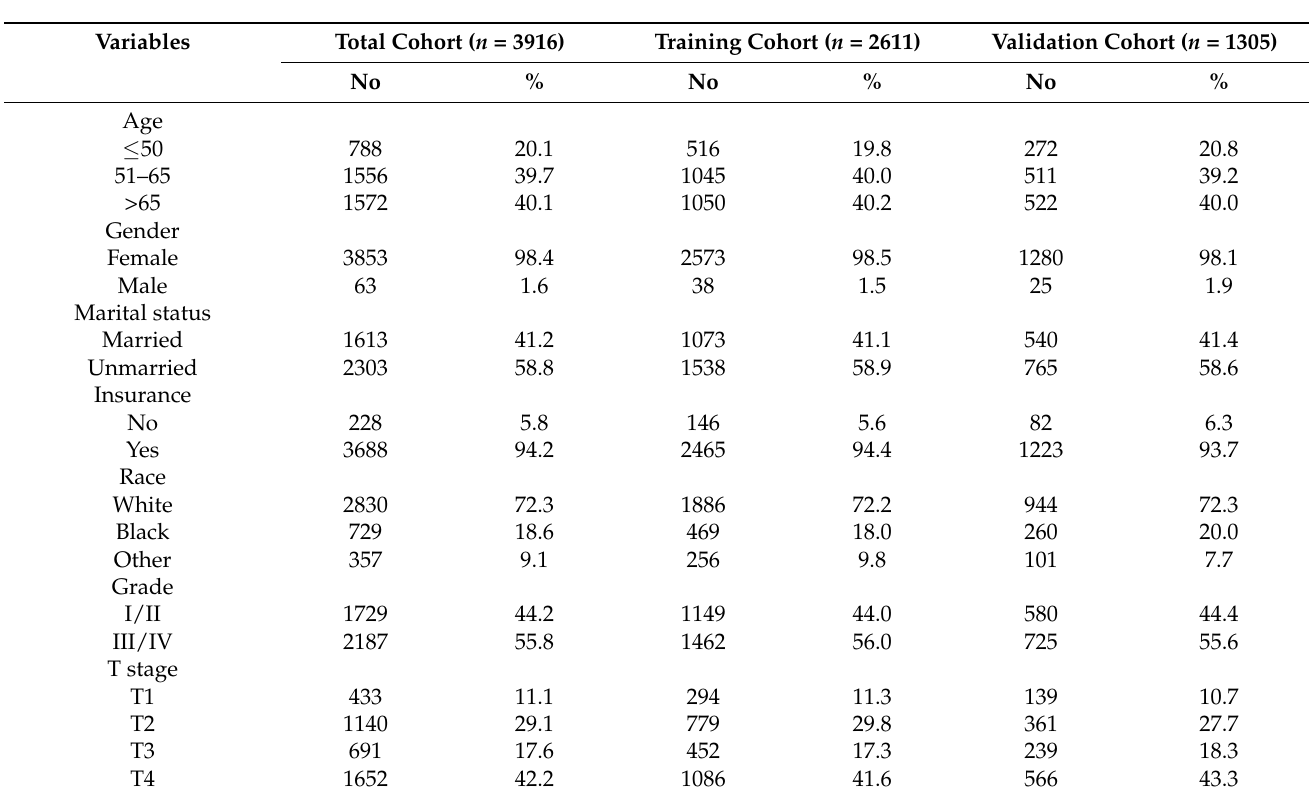
Table 1. Demographics and clinicopathologic characteristics of the cohort with breast cancer lung